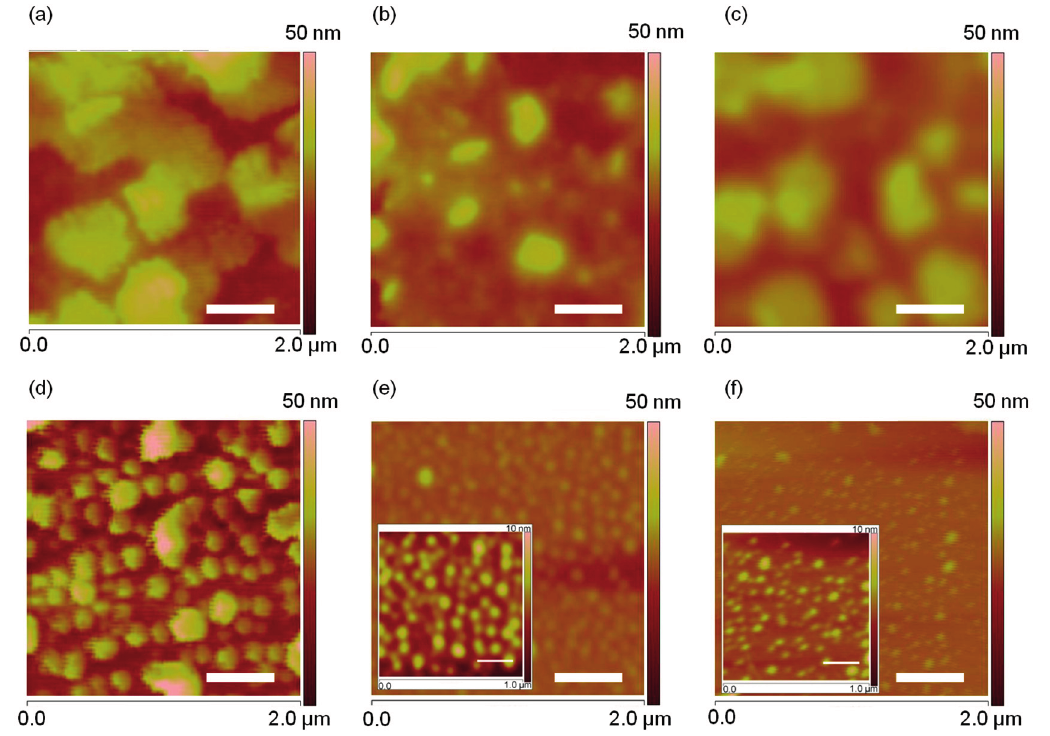
Figure 7. AFM images of the ( a ) LE(m)-1.35, ( b ) LE(m)-1.38, ( c ) LE(m)-1.53, ( d ) LE(m)-2.27, ( e ) LE(m)-2.75 and ( f ) LE(m)-2.78 micelles. The AFM image size and height are 2 µm × 2 µm and 50 nm, respectively (scale bar = 500 nm). The image size and height of the enlargement images are 1 µm × 1 µm and 10 nm, respectively (scale bar = 250